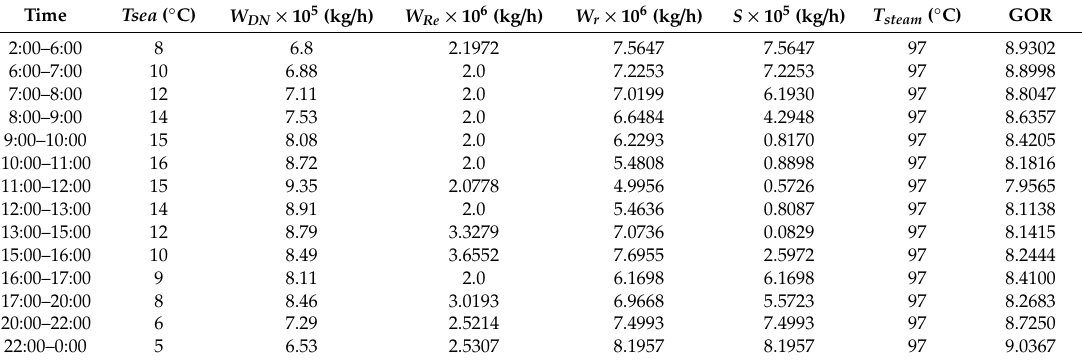
Table 6. States and optimal results obtained by solving Opt1 (optimal operation problem).